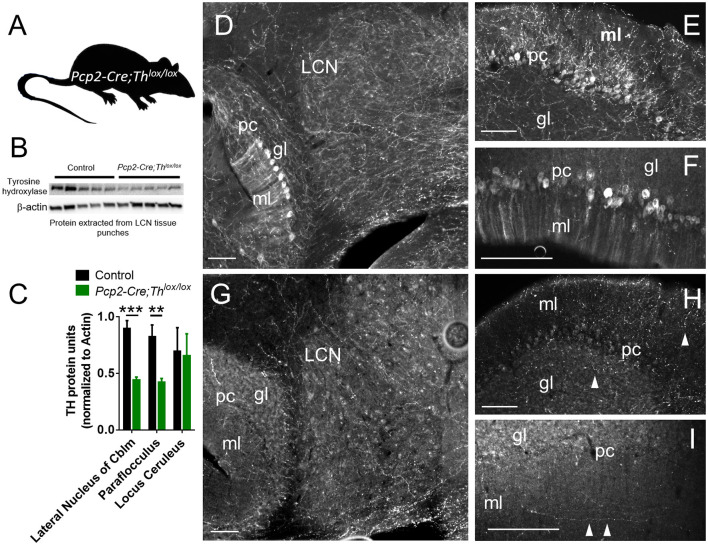
Generation and confirmation of mouse with conditional deletion of Th in Purkinje Cells. (A) Schematic for Purkinje Cell-specific knockout of Th: Pcp2-Cre mice crossed with Thlox/lox mice to generate Pcp2-Cre;Thlox/lox mice. (B) Western Blot from LCN with five representative controls on the left and five Pcp2-Cre;Thlox/lox mice on the right. The top band is Th, the β-actin band is on the bottom. (C) Quantification of Western Blots, from LCN, paraflocculus, and locus coeruleus. Error bars are SEM. Each Th band normalized to β-actin. ***p < 0.0003, one-tailed t-test, t(8) = 6.03. **p < 0.0065, one-tailed t-test, t(8) = 3.69. For LC comparison, p = 0.9. (D–I) Staining of Th in the red color channel in LCN, paraflocculus, and vermis (Lobule IX) of control (D–F) and Pcp2-Cre;Thlox/lox mice (G–I). Labels: ml = molecular layer, pc = Purkinje cell layer, gl = granule cell layer. Scale bars = 100 microns. The manipulation resulted in a significant reduction in the Th+ fibers innervating the LCN (D vs. G), and complete deletion of the Th signals in the PCs [D vs. G, E vs. H, for the paraflocculus, F vs. I for the posterior vermis (Lobule IX)], though some Th fibers (white arrowheads) are still present in the ml and gl layers in Pcp2-Cre;Thlox/lox mice, likely representing extrinsic sources of Th.